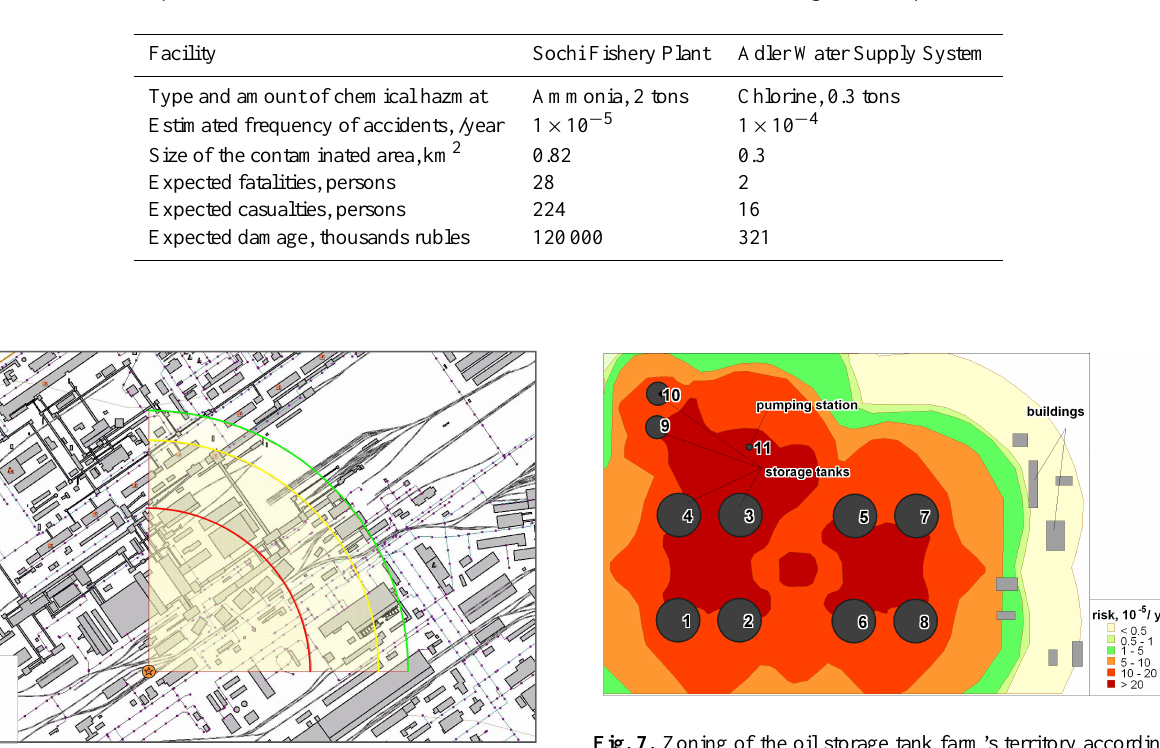
Table 6. Possible consequences of chemical hazmat release for two scenario accidents: most dangerous and probable events.